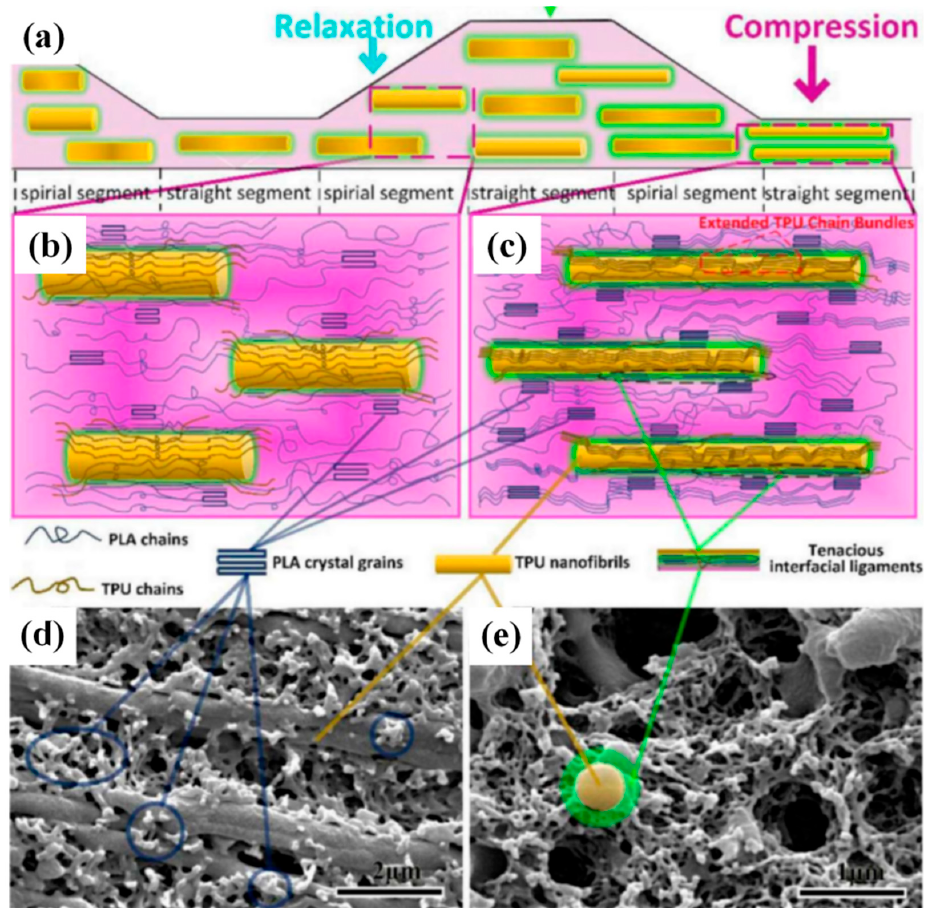
Figure 7. ( a ) Schematic of the formation process of thermoplastic poly(ether)urethane (TPU) nanofibers in ERE. The formation of poly- L -lactic acid (PLA) crystal grains in ( b ) relaxation and ( c ) compression channel. The SEM images of ( d ) etched and ( e ) ultrasonic cleaned fractures. Reproduced with permission from [44]. Copyright 2019, Elsevier.